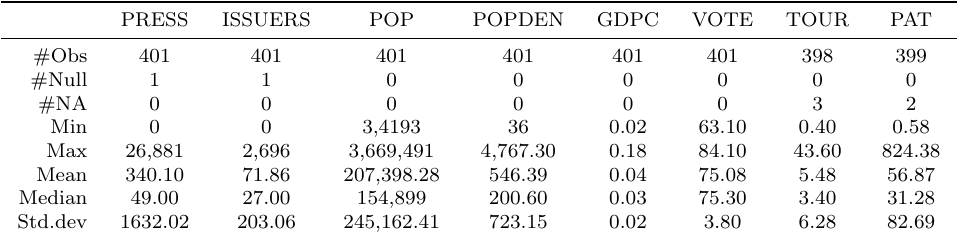
Table 1: Descriptive statistics